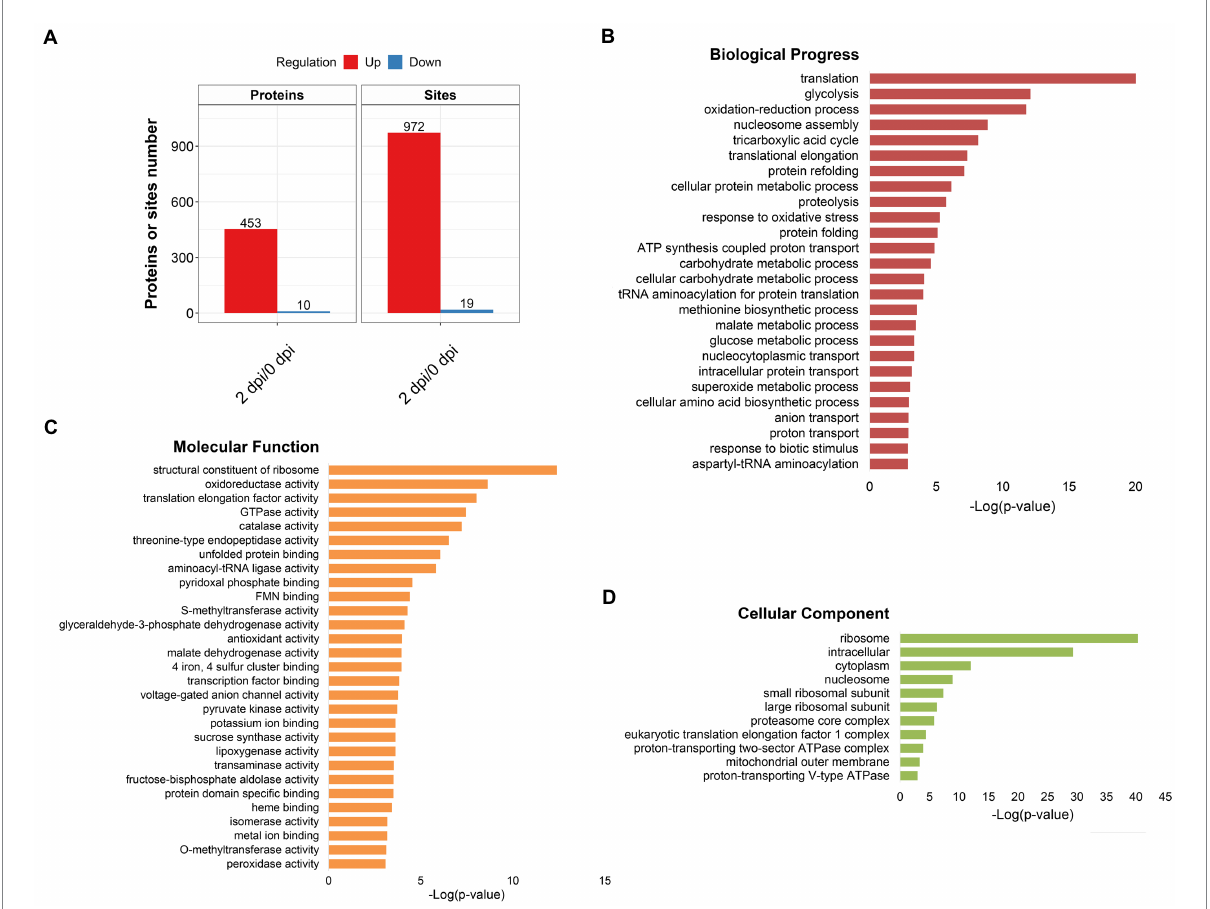
FIGURE 4 Identification and functional classification of Khib-modified proteins. (A) Numbers of up- and down-regulation proteins and Khib modification sites. (B–D) Gene ontology enrichment of upregulated differentially expressed proteins between 0 and 2 dpi. Biological progress (B) , Molecular function (C) , and Cellular component (D) . Fisher’s exact test, value of p was adjusted using the Benjamini-Yekutieli method, FDR <